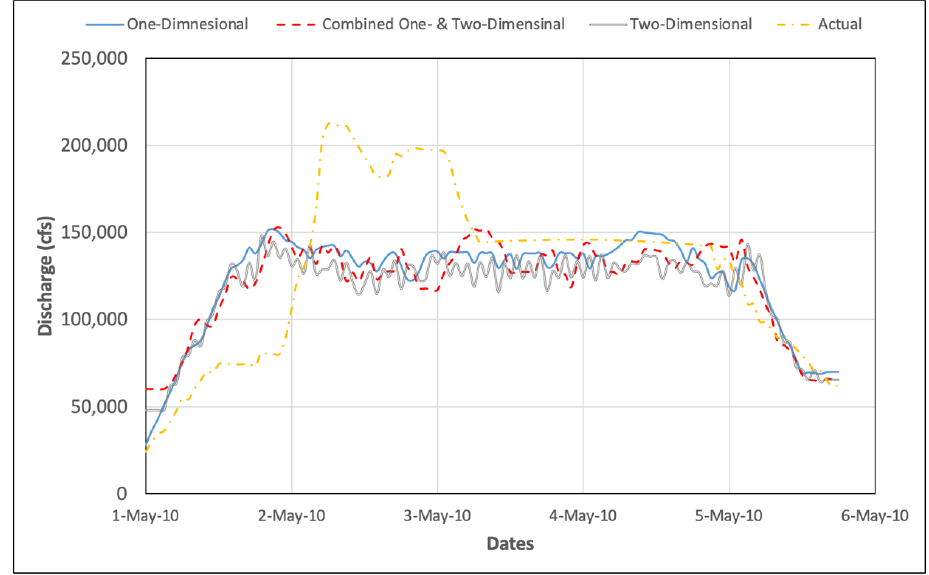
Figure 15. Optimized and Actual Releases at Old Hickory Dam during May 2010 Flooding Event.